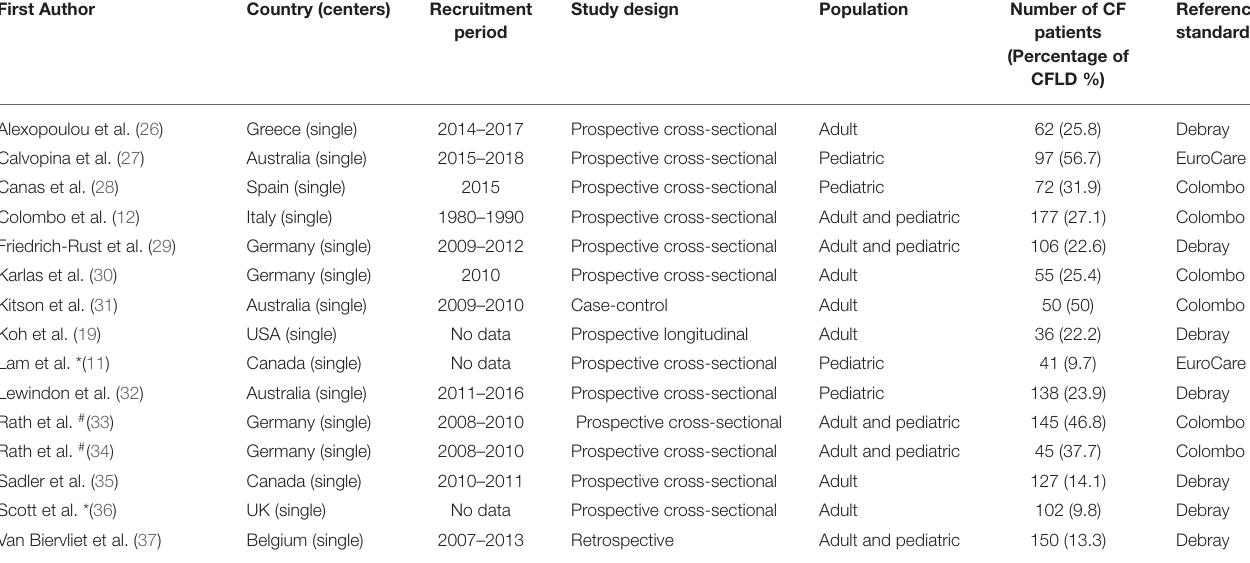
TABLE 1 | Baseline characteristics of the included